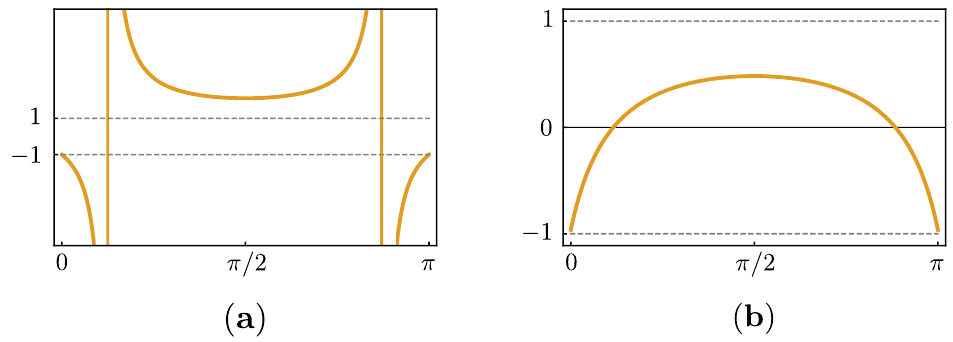
Figure 7 . Panel (a) shows a CDD pole [ (cid:25)= 8] for (cid:18) purely imaginary between 0 and i(cid:25) . Note that the magnitude of this factor is always greater or equal 1. Also note that it is positive between its s - and t - channel poles, while the tails of the function are negative. Panel (b) shows a CDD zero [ (cid:25)= 8] in the same interval. The magnitude of this function in this interval is always less than or (cid:0) equal to